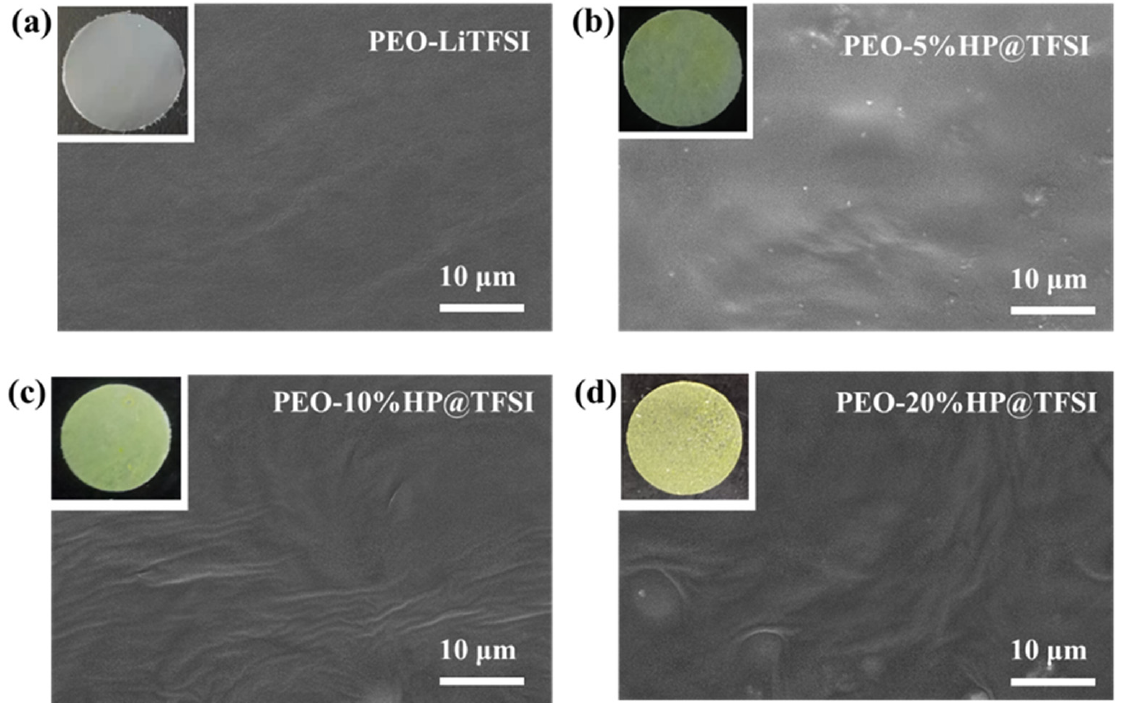
Figure 3. Photos and SEM images of ( a ) PEO-LiTFSI; ( b ) PEO-5%HP@TFSI; ( c ) PEO-10%HP@TFSI; Figure 3. PhotosandSEMimagesof( a )PEO-LiTFSI;( b )PEO-5%HP@TFSI;( c )PEO-10%HP@TFSI;( d )PEO-20%HP@TFSImembranes. ( d ) PEO-20%HP@TFSI membranes. The X-ray diffraction patterns (XRD) of PEO and electrolytes with different HP@TFSI content were analyzed. It can be seen from Figure 4a that there are two obvious peaks in pure PEO phase at 19 ◦ and 23 ◦ corresponding to (120) and (112) crystal faces